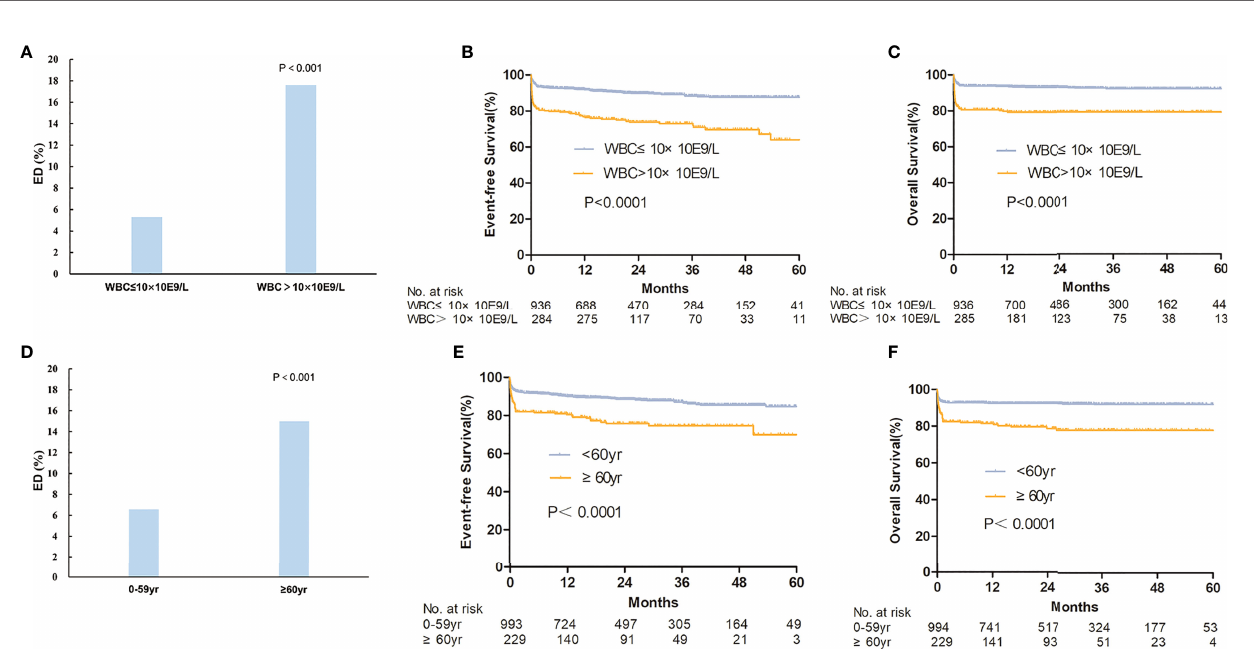
FIGURE 3 | The survival between different risk groups and ages. The early death rate (A) and estimated survival (B, C) were compared between high-risk group (WBC>10×10E9/L) and non-high-risk group (WBC ≤ 10×10E9/L). The early death rate (D) and estimated survival (E, F) were also compared between patients ≥ 60 years and <60